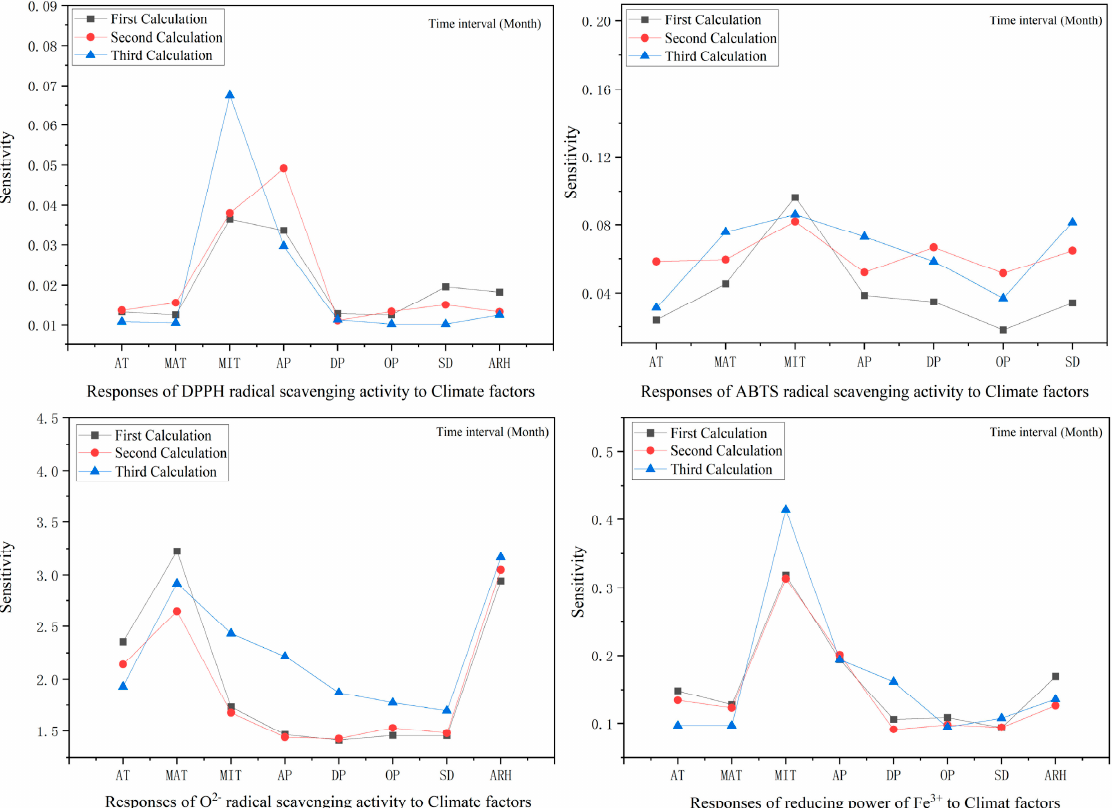
Figure 5. Response of antioxidant activity to climate factors.